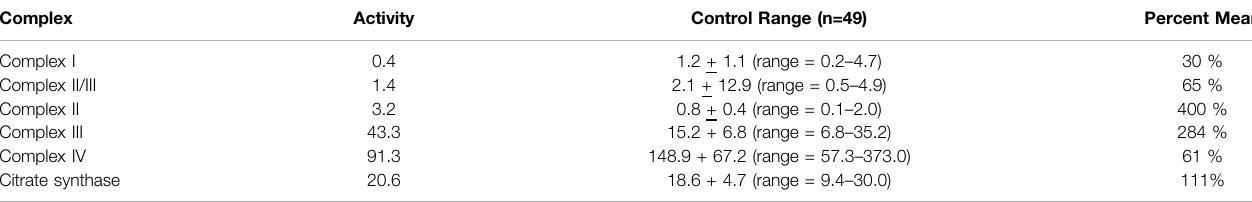
TABLE 3 | Spectrophotometry analysis of electron transport chain enzyme activity from muscle biopsy material. These results are from the muscle biopsy from the patient with TANGO2 gene variants.